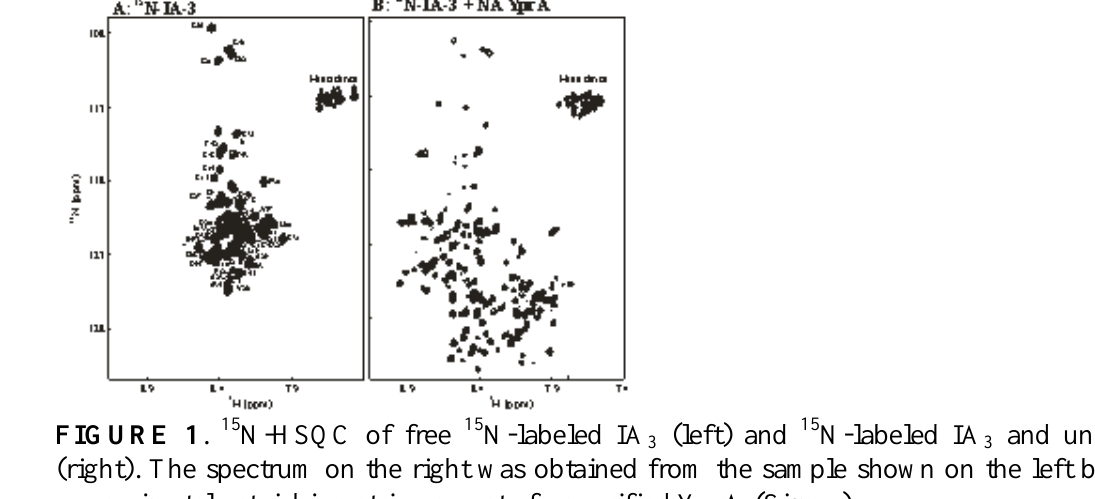
(left) and 15 N-labeled IA and unlabed YprA 3 3